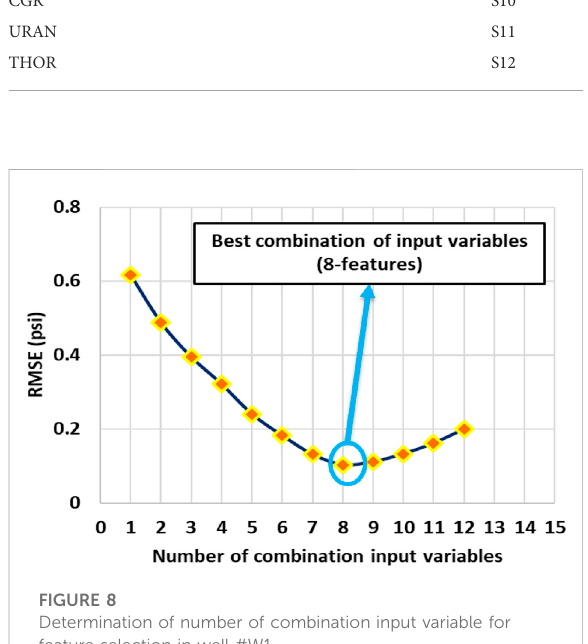
FIGURE 8 Determination of number of combination input variable for feature selection in well